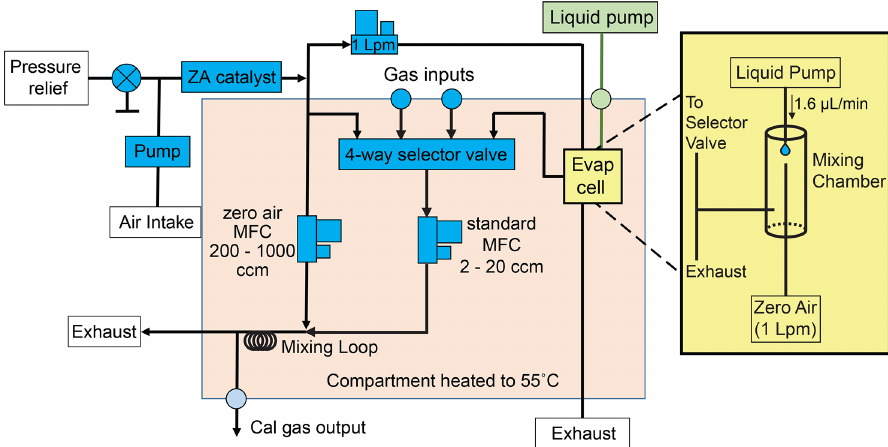
Figure 3. Schematic of dynamic dilution system for VOC and IVOC calibration. Gas cylinders or liquid mixtures can be used for calibration. Liquid mixtures are introduced into an evaporation cell using a syringe pump. The liquid is evaporated into 1Lmin − 1 of zero air to reach parts-per-million or lower concentrations. The resulting gaseous mixture (or, by user choice, the output of a calibration gas cylinder) is subsampled with a 2–20cm 3 min − 1 MFC and further diluted up to 500 times with more zero air before being sampled by the I/VOC collector. Zero air for the dilution system is generated by passing ambient air through a heated platinum